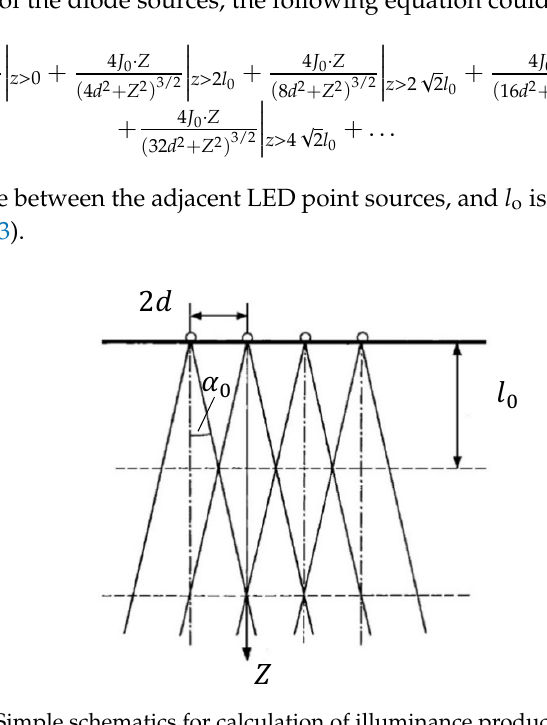
Figure 3. Simple schematics for calculation of illuminance produced by flat PMTS.